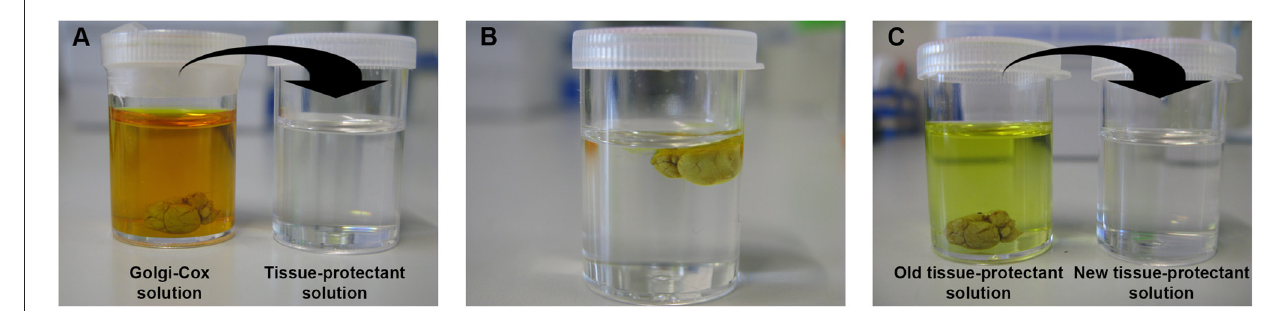
FIGURE 2 | Tissue protection step . The brain sample is transferred from the Golgi-Cox impregnation solution to a new bottle with tissue-protectant solution and kept at 4 ◦ C in the dark (A,B) . After 24 h, the tissue-protectant solution is replaced by a fresh solution in a new bottle (C) .